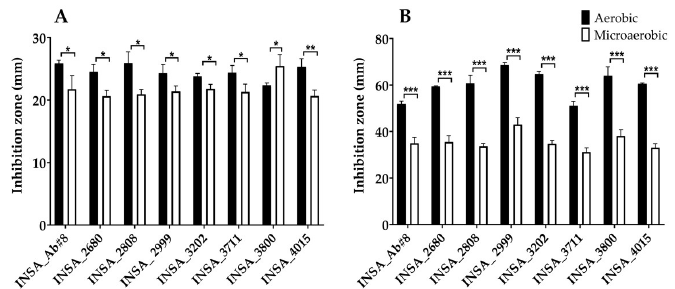
Figure 1. Susceptibility of eight clinical isolates of Arcobacter butzleri to oxidative stress when exposed to ( A ) 10% of hydrogen peroxide or ( B ) 125 mM of methyl viologen when grown in aerobic or microaerobic conditions. Results were analysed between atmospheric conditions using Student’s t -test. The data shown represent the mean ± standard deviation of at least three independent assays.